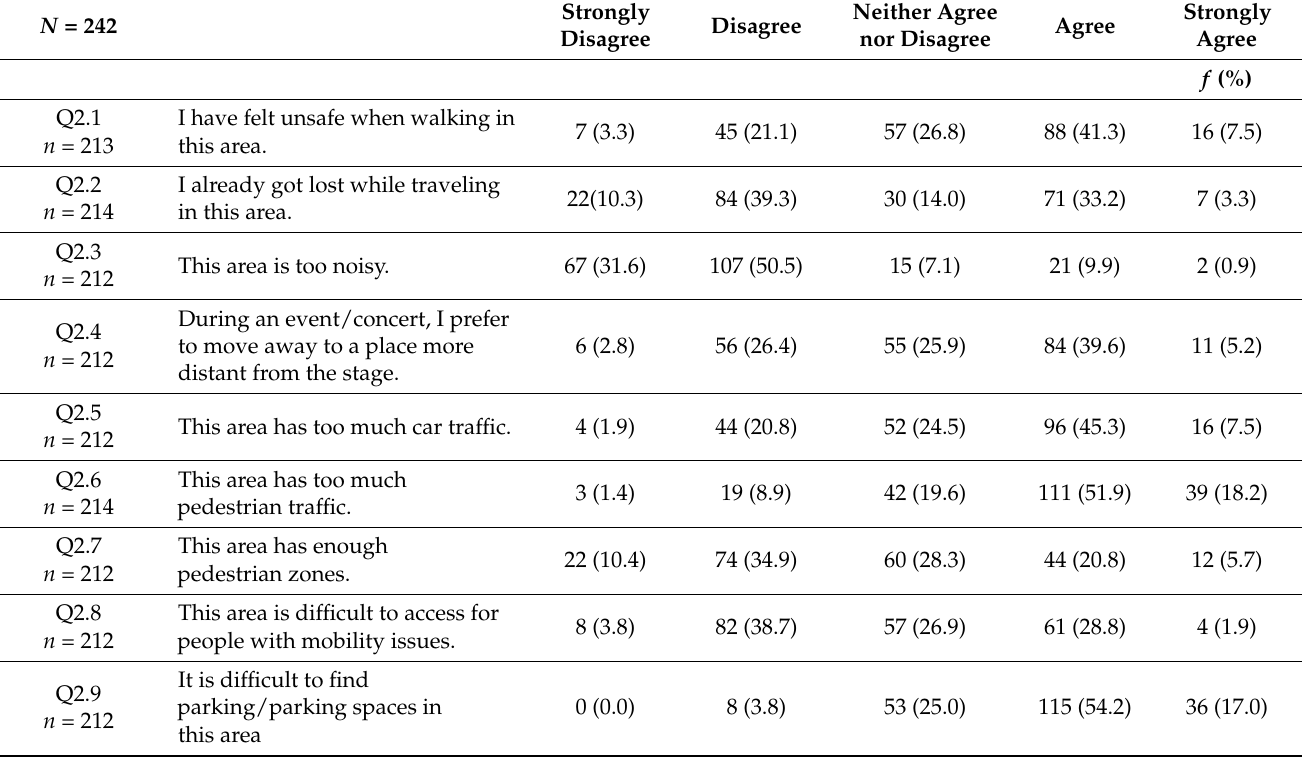
Table 3. Surveyed population agreement ratios about positive and negative area